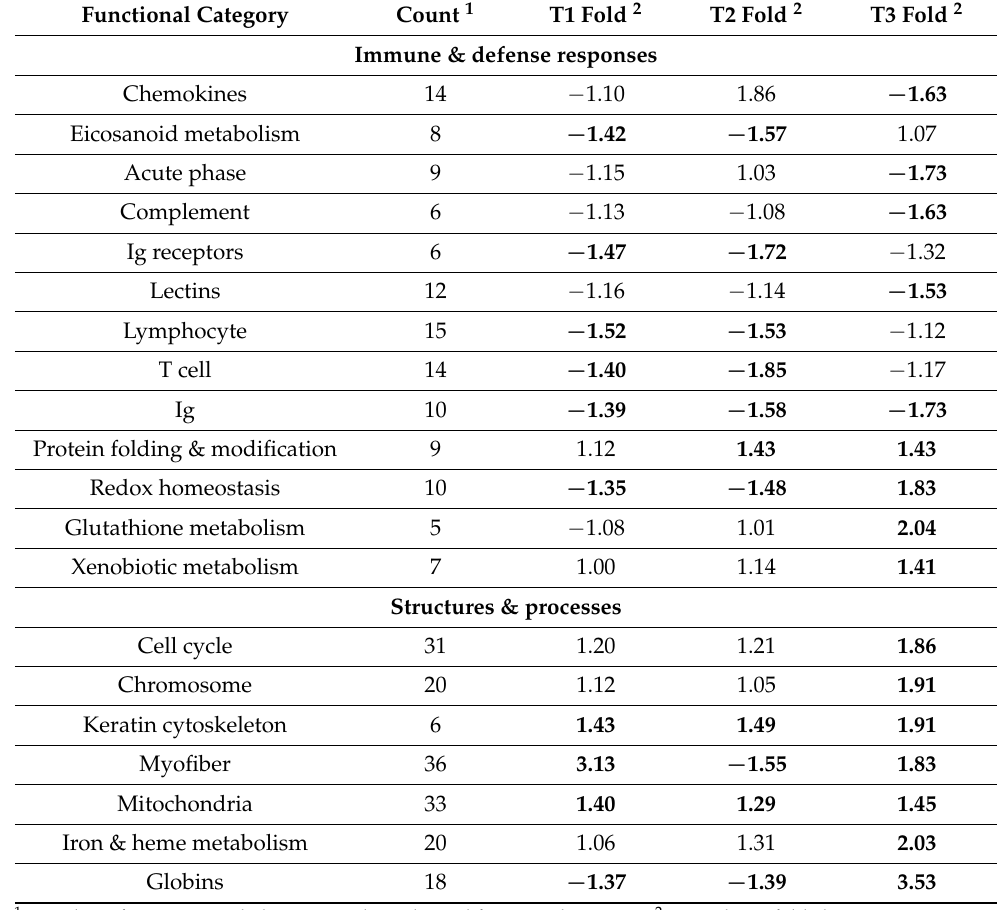
Table 7. Enriched STARS functional groups in HK. Significant differential expression is highlighted in